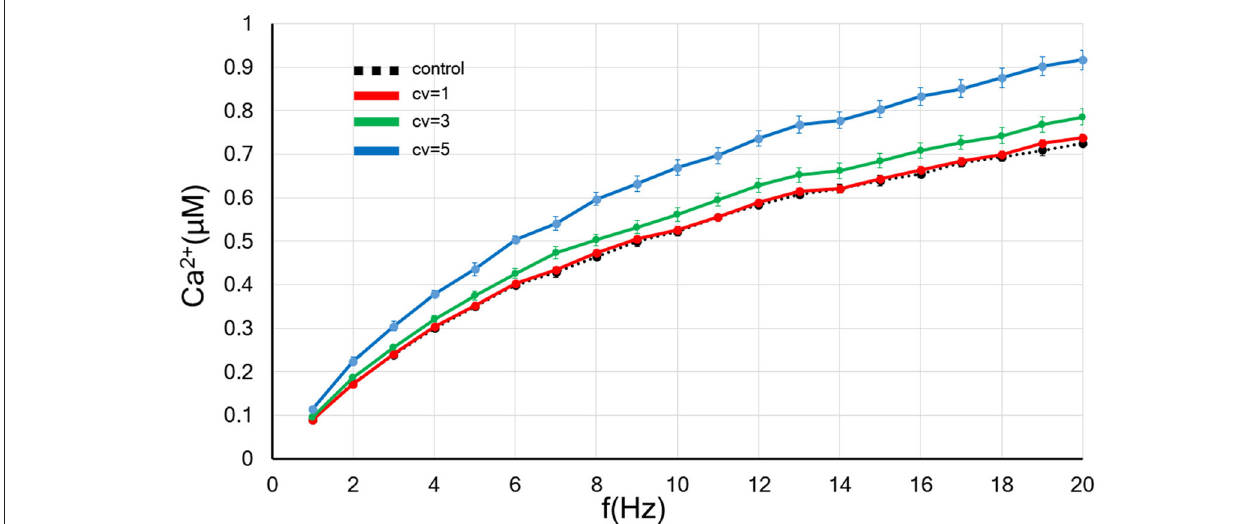
FIGURE 2 | The CV of the amplitude for the background synaptic activity regulates the frequency-dependence of the postsynaptic calcium concentration. The x -axis shows the input frequency, and the y -axis indicates the postsynapitc calcium concentration. A black dotted line indicates the control without applied the fluctuation. The red, blue and green lines show the results of background synaptic activity with fluctuations in the CV = 1, 3, and 5. Error bars indicate the standard error of the mean (SEM).